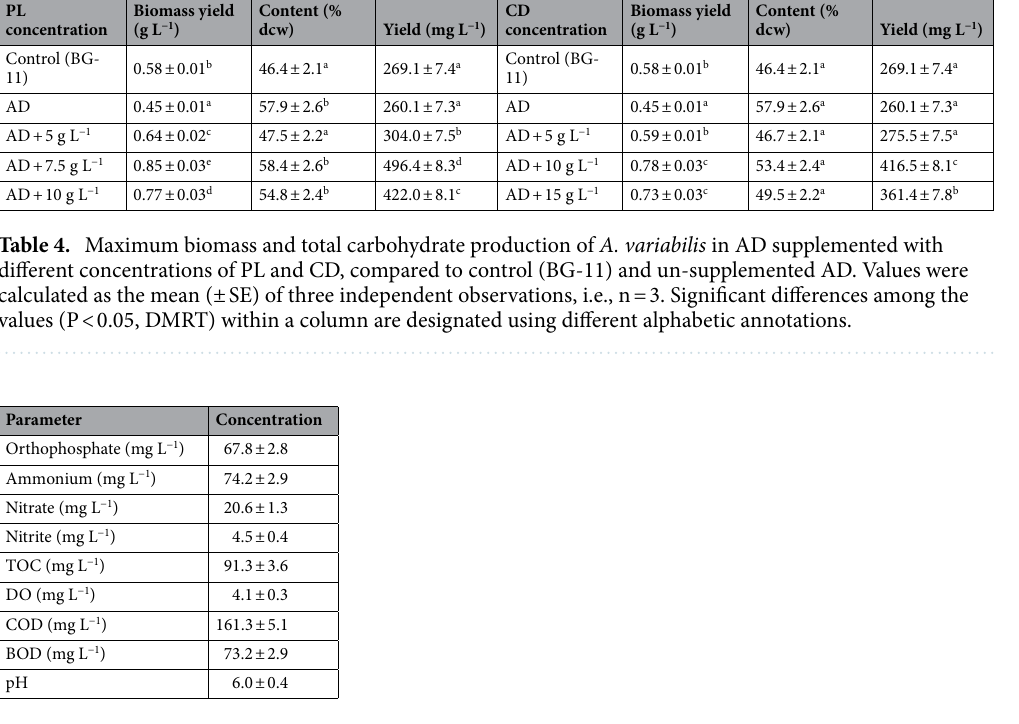
Parameter (mg L −1